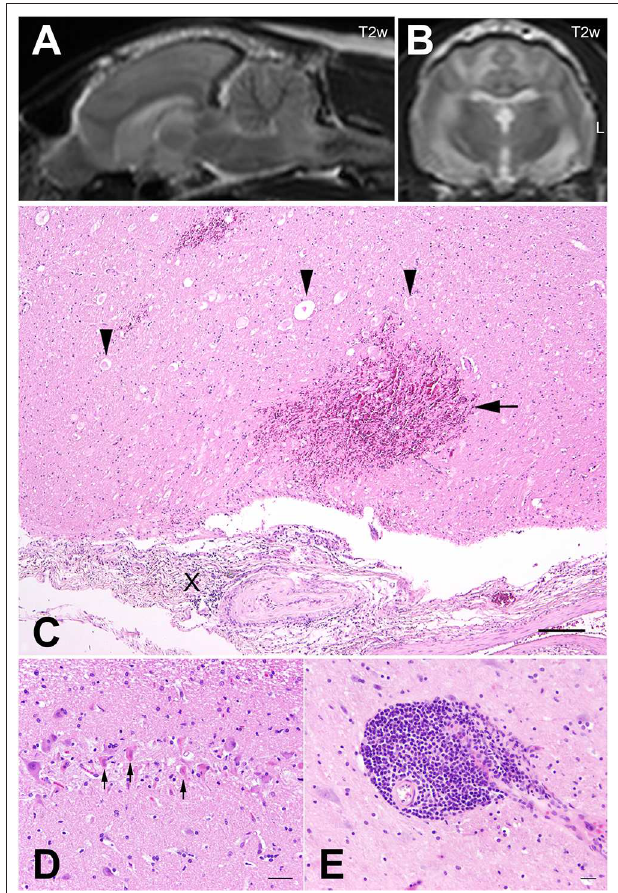
FIGURE 2 | Cat no. 2. (A,B) Magnetic resonance imaging (MRI): Midsagittal (A) and transversal section (B) of the brain of cat 2 at the level of the interthalamic adhesion in T2 weighted (T2w) sequences. Note the intramedullary hyperintense lesions of the brainstem and the subcortical white matter as well as the mass lesion with signal void in the myelencephalon. Left side is marked with L. (C–E) Histopathology. (C) Pons, focally severe meningitis (X) with severe hemorrhages in the adjacent neuroparenchyma (arrow) and vacuolization of the white matter as well as spheroids (arrowheads), HE, bar = 100 µ m. (D) Hippocampus, severe neuronal necrosis (arrows) and loss. HE, bar = 50 µ m. (E) Cerebral cortex with focally severe, perivascular, lympho-histiocytic encephalitis. HE, bar = 60 µ